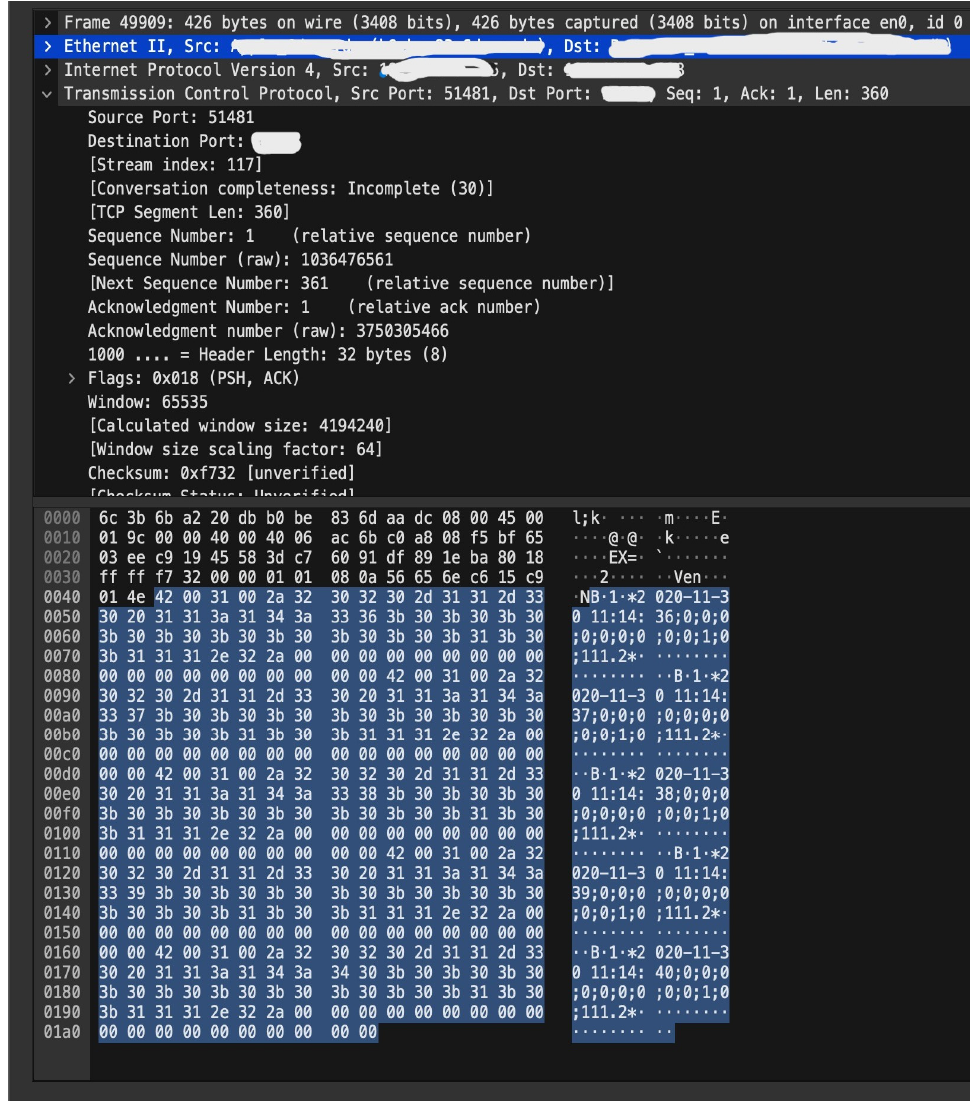
Figure 11. Readable data from eavesdrop attack on GSM-R via unsecured network, and the data could be understood by malicious party.